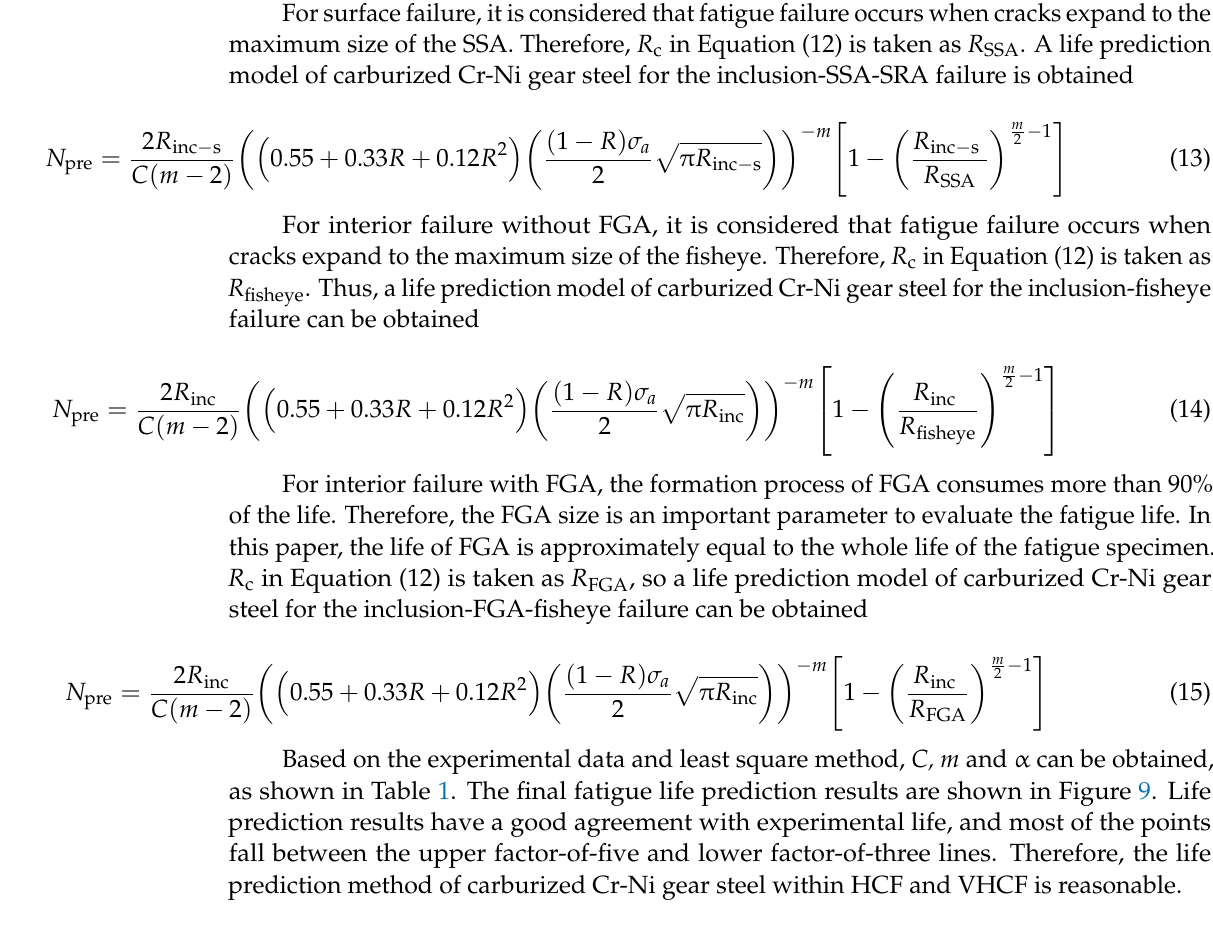
Table 1. Best-fit value for identified parameters ( C, m and α ) in Equation